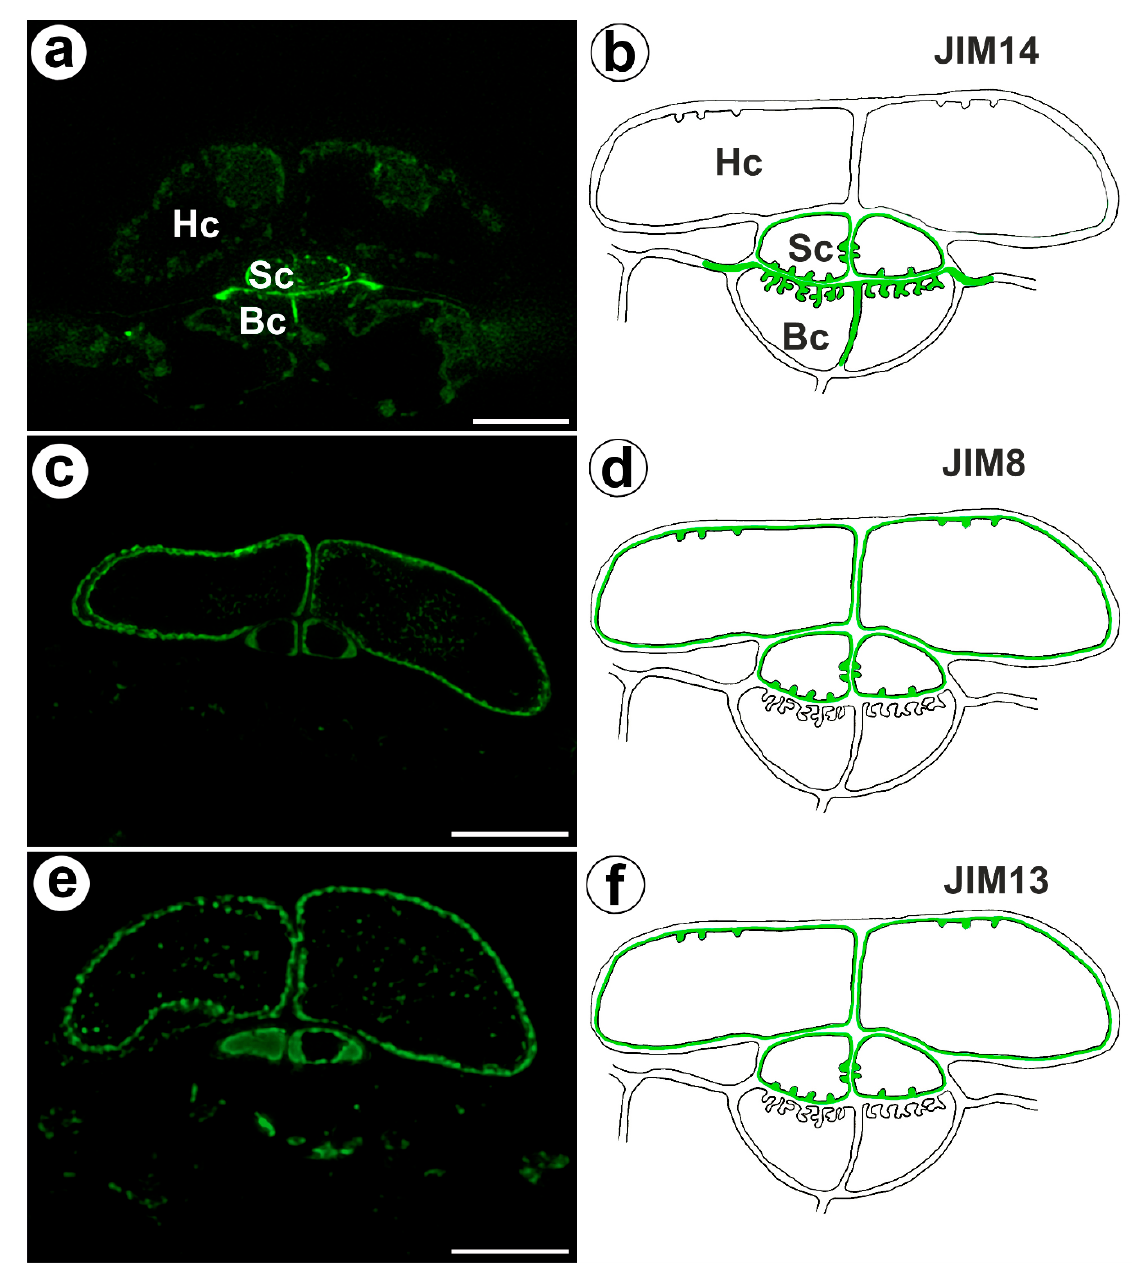
Figure 2. Arabinogalactan proteins detected in the bifid trichomes of the Aldrovanda vesiculosa traps. ( a ) Arabinogalactan proteins (labeled with JIM14) were detected in the trichomes, head cell (Hc), stalk cell (Sc), basal cell (Bc), and bar 10 µm. ( b ) Schematic occurrence (green) of the arabinogalactan proteins (labeled with JIM14) detected in trichome, head cell (Hc), stalk cell (Sc), and basal cell (Bc). ( c ) Arabinogalactan proteins (labeled with JIM8) were detected in trichomes, bar 10 µm. ( d ) Schematic occurrence (green) of the arabinogalactan proteins (labeled with JIM8) detected in a trichome. ( e ) Arabinogalactan proteins (labeled with JIM13) detected in trichomes, bar 10 µm. ( f ) Schematic occurrence (green color) of the arabinogalactan proteins (labeled with JIM13) detected in a trichome.